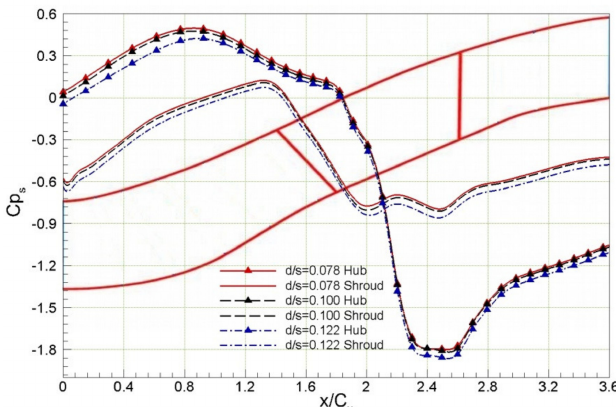
Figure 9. Time-averaged wall static pressure coefficient on the hub and shroud of the